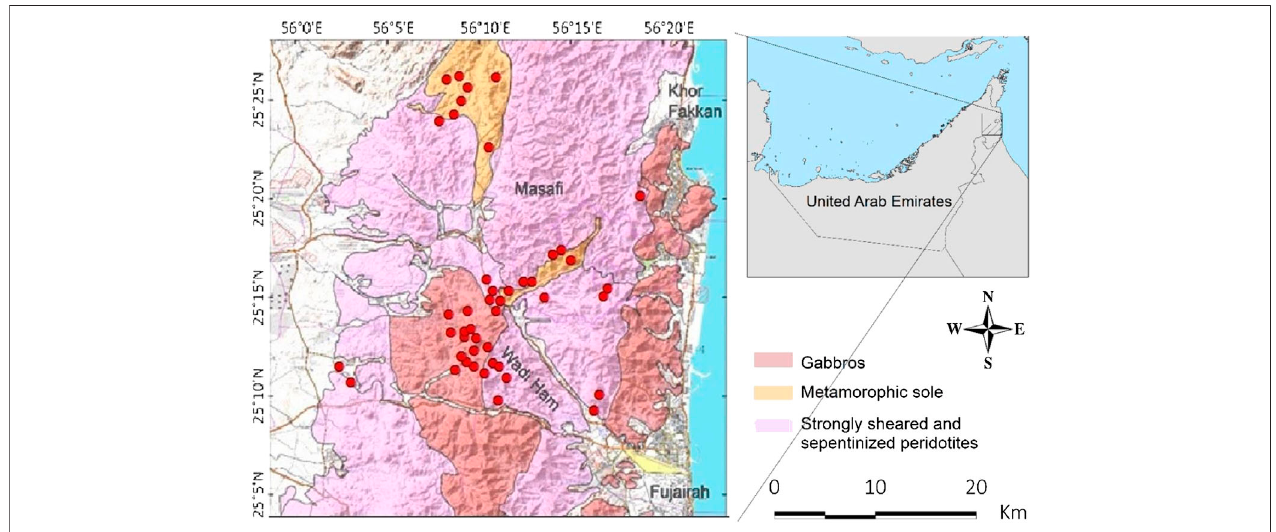
Frontiers in Earth Science |